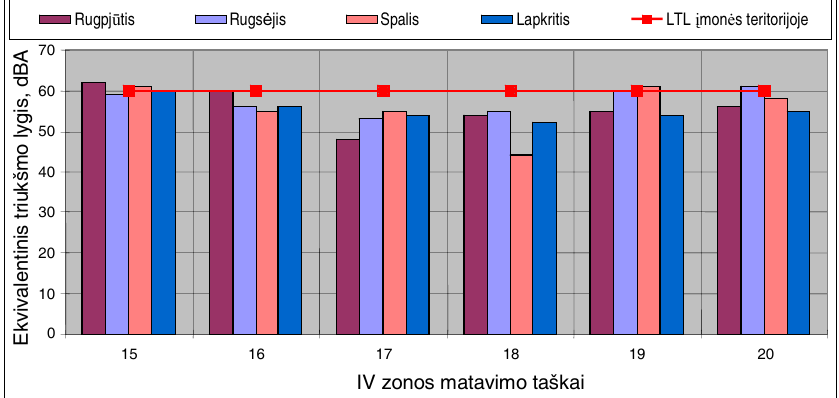
Fig 5. Measuring points of day-time reciprocal noise level on residential territory of zone IV